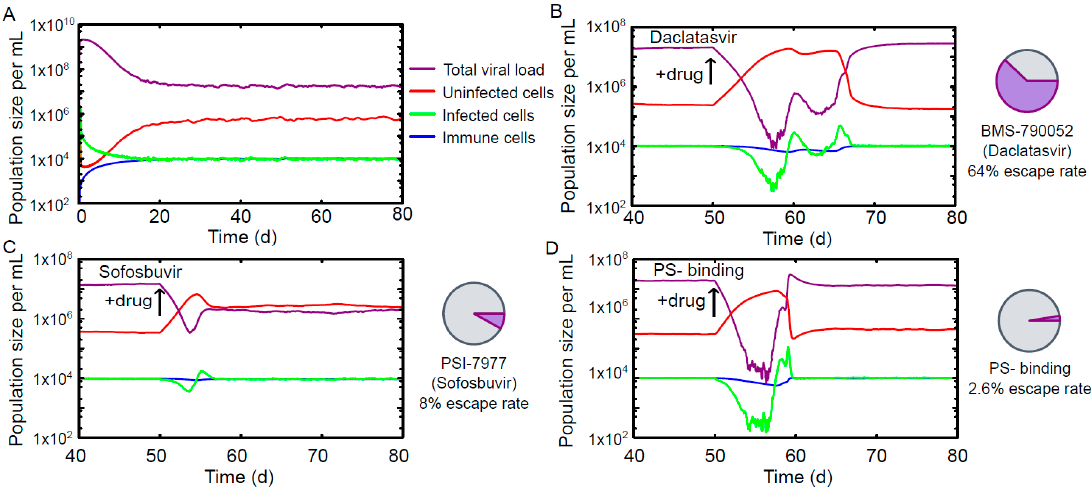
Figure 2. The time course of a chronic infection based on data for Hepatitis C virus. ( A ) Time evolution of viral load, host, infected and immune cells in the drug-free case. 20 days after the initial infection, the population sizes have reached a stable equilibrium corresponding to a viral load of 10 7 /mL. Typical time courses for viral quasispecies that have developed resistance to Daclatasvir ( B ); Sofosbuvir ( C ); and a PS-binding assembly-inhibitor ( D ). The probability of the quasispecies developing therapy resistance is significantly lower for the PS-binding drug. At the drug concentration for which infection of a single cell with the wild-type sequence results in the same number of viral particles at cell burst under treatment with Sofosbuvir and the PS-binding drug (8.07 µ M); the drug escape for the PS-binding drug is 2.6%, compared with 8% for Sofosbuvir. A similar comparison with Daclatasvir using a PS-binding drug concentration of 10.30 µM results in a drug escape rate of 1.7% for the PS-binding drug (not shown), compared with 64% for Daclatasvir.